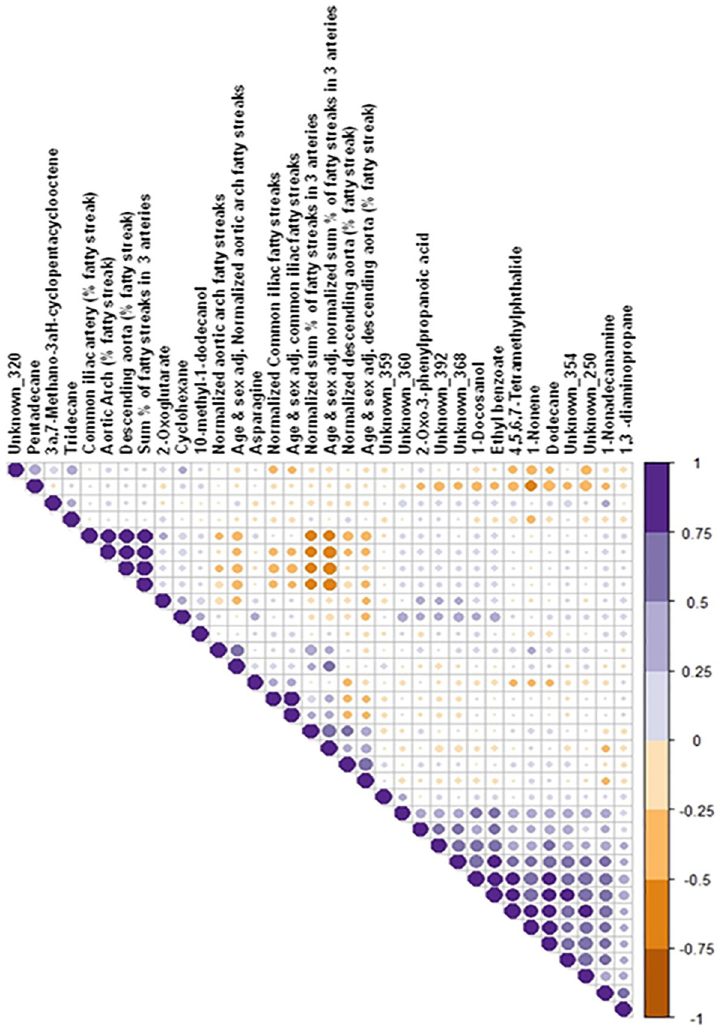
Fig 6. Correlation of atherosclerotic phenotypes (lesion percentage distribution as fatty streak and/ plaque distribution and numbers) with the metabolite abundances. Correlations are in a scale of +1 (positive, purple) to -1 (negative,